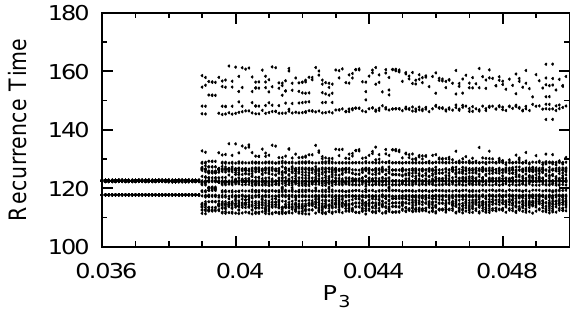
Figure 11. Bifurcation diagram of recurrence intervals of slip events at Block 1 near the transition boundary between periodic patterns and complex pattern 3. The model parameters are K = 0 . 20, P 1 = 0 . 500, and P 2 = 0 . 500, and P 3 ranges from 0.036 to